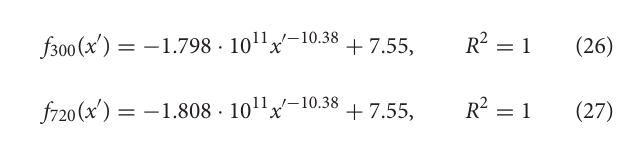
functions on top of the median ratings and interquartile ranges for the sound sets with f0s at 120, 300, and 720 Hz. The abscissa corresponds to log-transformed values of the odd-to- even ratio, and the arbitrary units on the ordinate represent equal odd-to-even ratio distances as perceived by the